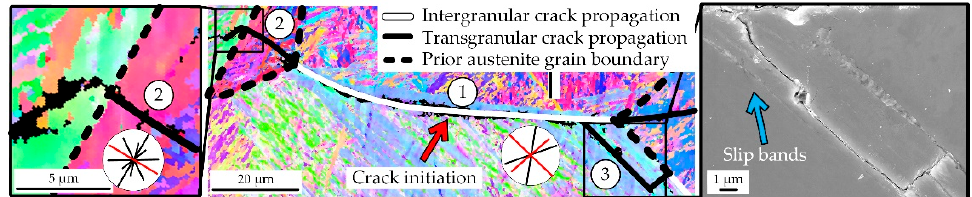
Figure 11. EBSD analysis with calculated {110} glide plane traces (active glide traces marked in red) and SEM image of an NSP sample after 155,000 cycles at Δσ /2 = 680 MPa. The numbers in the EBSD analysis mark the breakpoints of the crack.